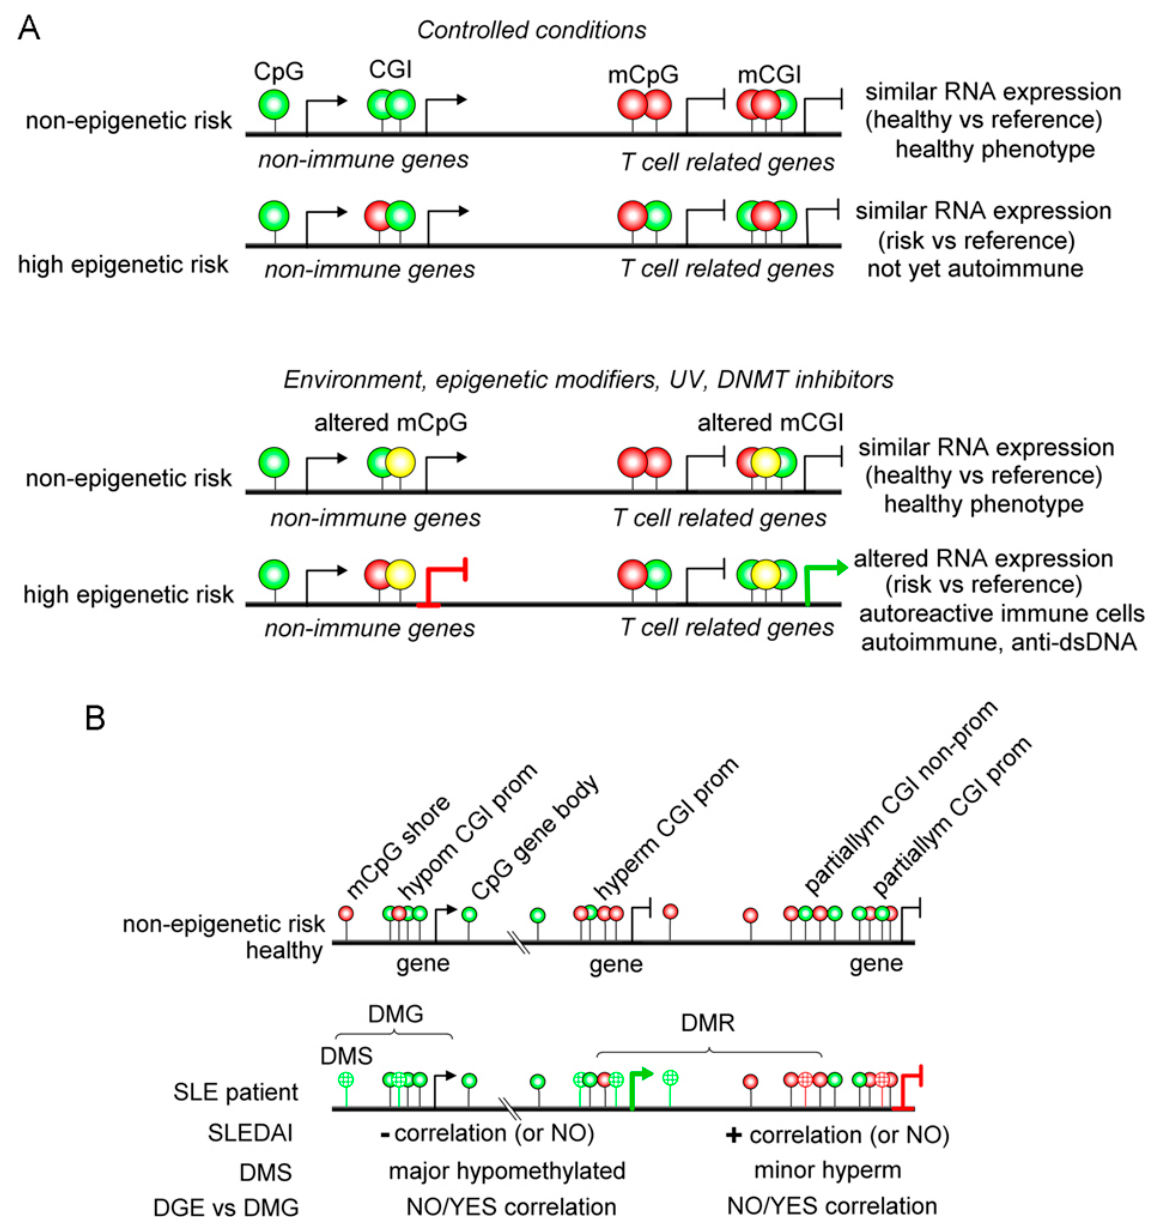
Figure 3. Hypothetical mechanism of DNA methylation in autoimmunity. ( A ) Autoimmune-susceptible hosts may carry genetic risk and an altered DNA methylation status, including hypomethylated (green circles) and hypermethylated (red circles) CpG sites. However, this inheritable genetics is not sufficient to develop autoimmunity, as observed in monozygotic twins. Environmental agents, stress, UV, and epigenetic modifiers may alter methylated DNA status (yellow circles), leading to aberrant gene expression or repression. However, only high genetic-risk hosts may develop autoreactive immune cells resulting in autoimmune disease phenotype over time. ( B ) SLE methylome features on T cells. Lupus patients display differentially methylated regions (DMR) which are shaped by genes (differential methylation genes - DMG) and sites (DMS—grid circles). Most of the DMG/DMS seen in SLE display hypomethylated (green grid circles) patterns that may negatively correlate with SLE disease activity index (SLEDAI) and not often with gene expression. Hypermethylated (red grid circles) DMG/DMS is also seen in SLE patients that may positively associate with SLEDAI and not so often with gene expression. Genes could also be partially methylated (partiallym in the scheme).